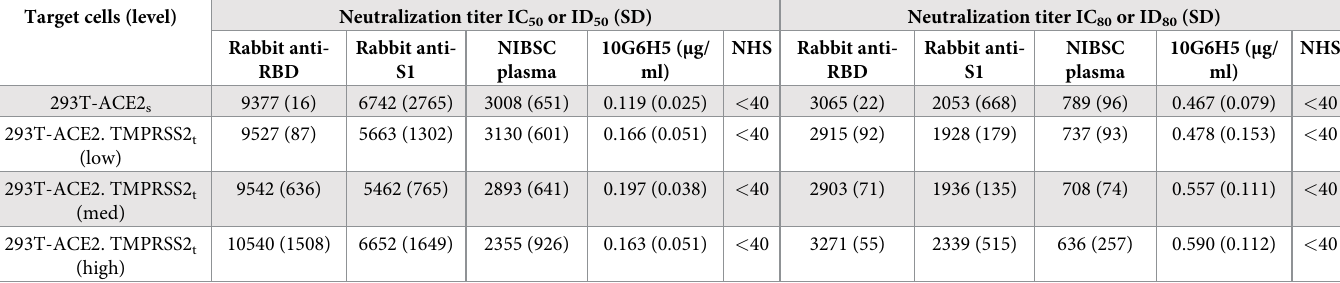
NHS: Negative control human sera, SD: Standard deviation.